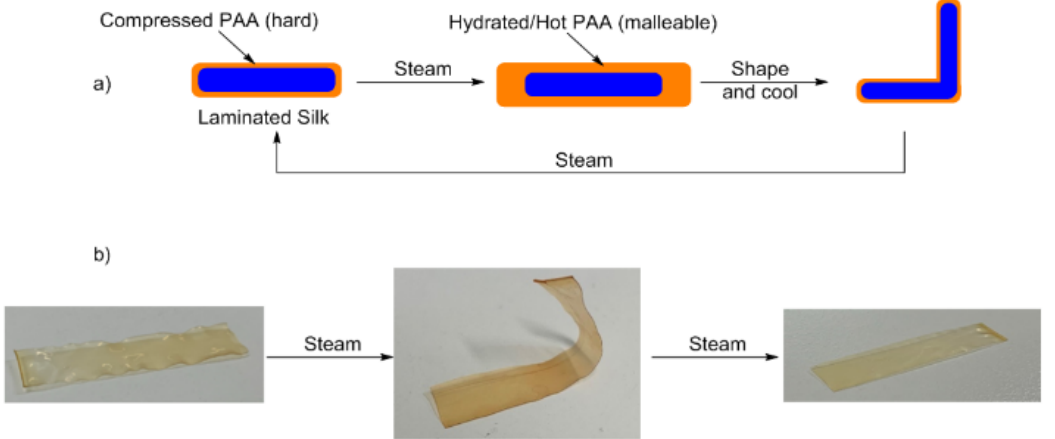
Figure 9. ( a ) Schematic of mouldable silk membranes and their reversible forming; ( b ) before and after moulding in steam for membranes functionalised using the 3-(trifluoromethyl)benzenediazonium salt 7 (larger image in ESI).